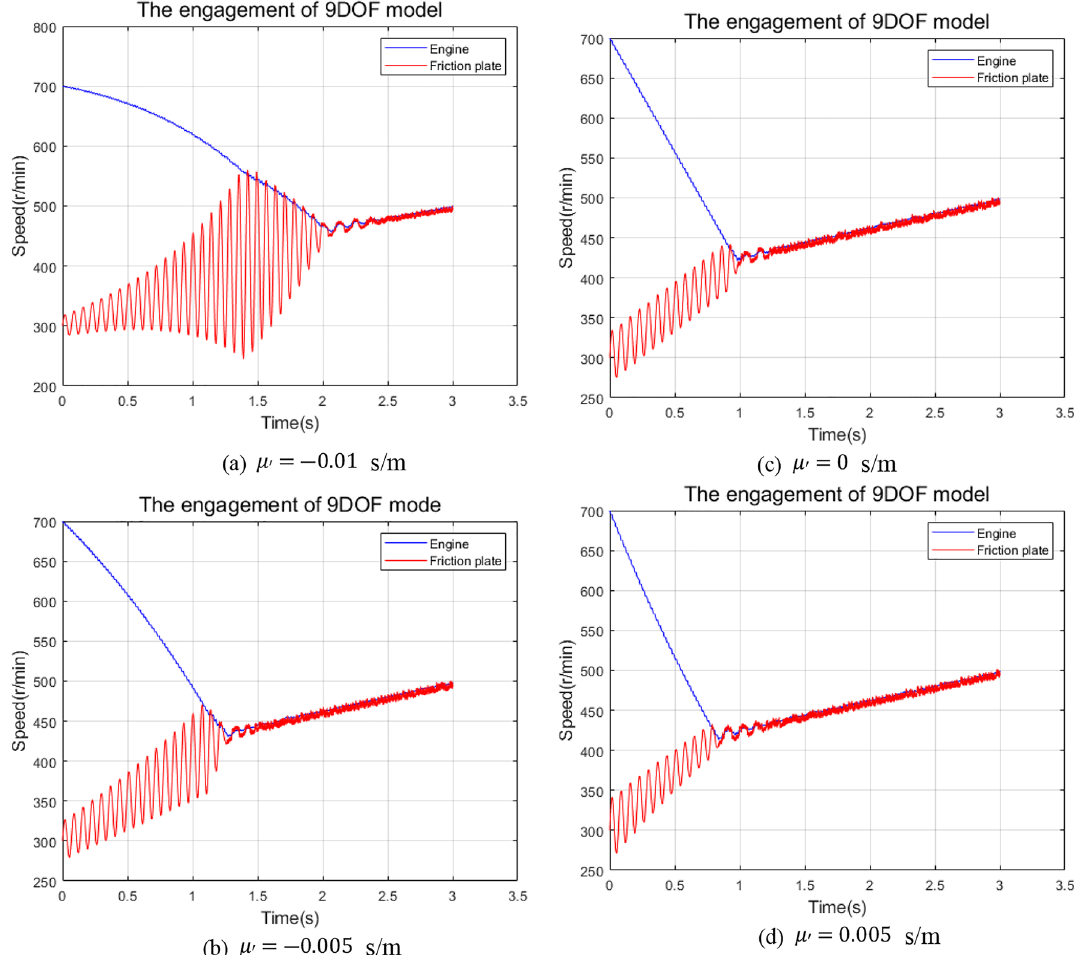
Figure 5 Simulation diagrams for different friction gradients ( a ) µ ′ = − 0.01 s/m ( b ) µ ′ = − 0.005 s/m ( c ) µ ′ = 0 s/m ( d ) µ ′ = 0.005 s/m